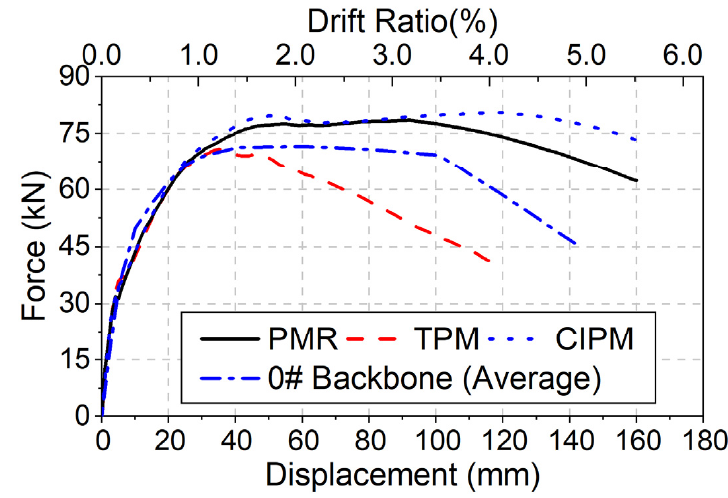
Figure 8. Force–displacement curves of TPM, CIPM and PMR.